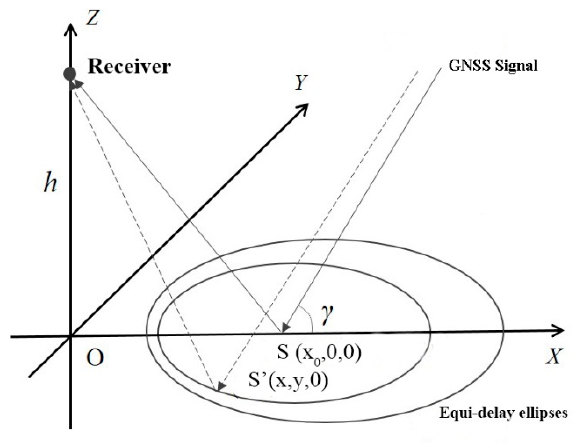
Figure 4. Schematic diagram of equi-delay ellipses of the reflected GNSS signal.